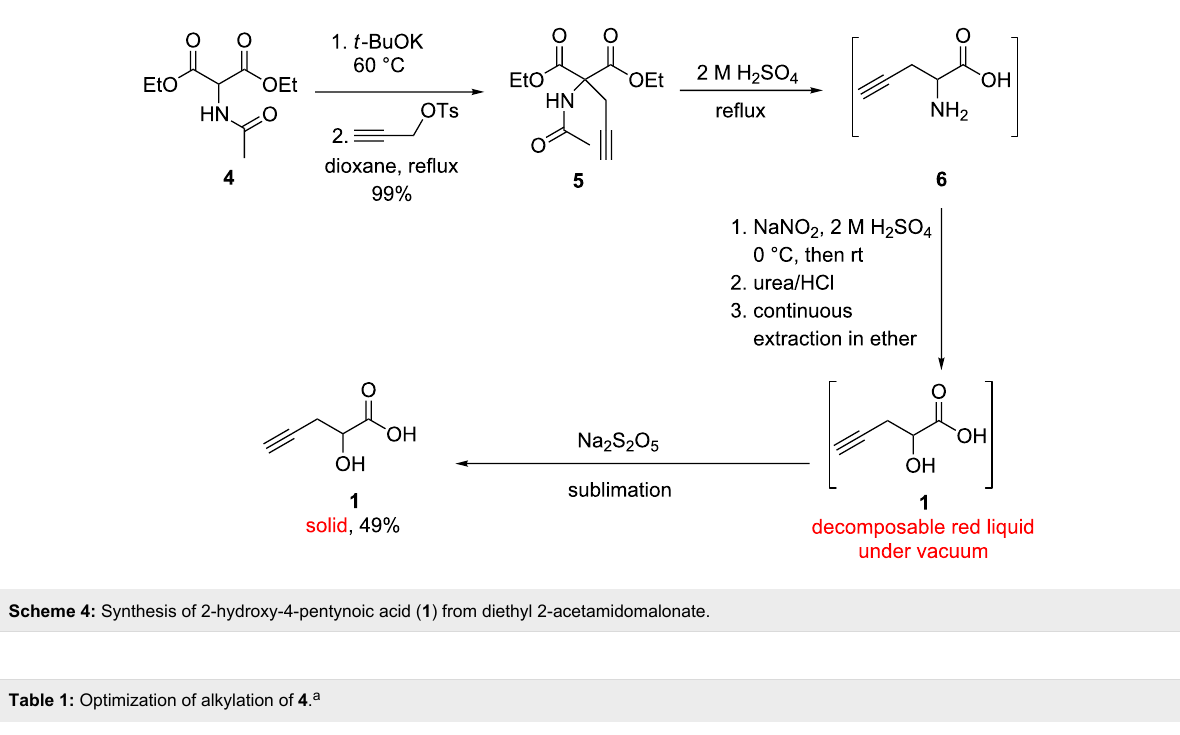
Table 1: Optimization of alkylation of 4 . a